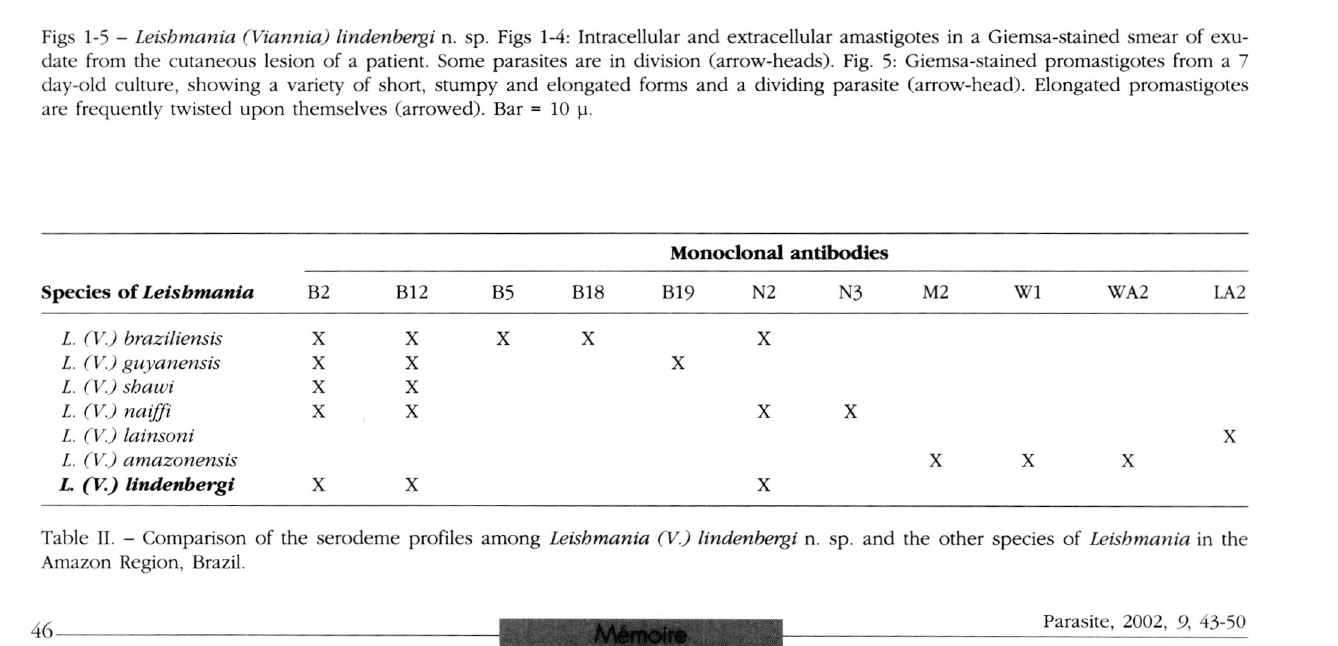
Table II. - Comparison of the serodeme profiles among Leishmania (V.) lindenbergi n. sp. and the other species of Leishmania in the Amazon Region,